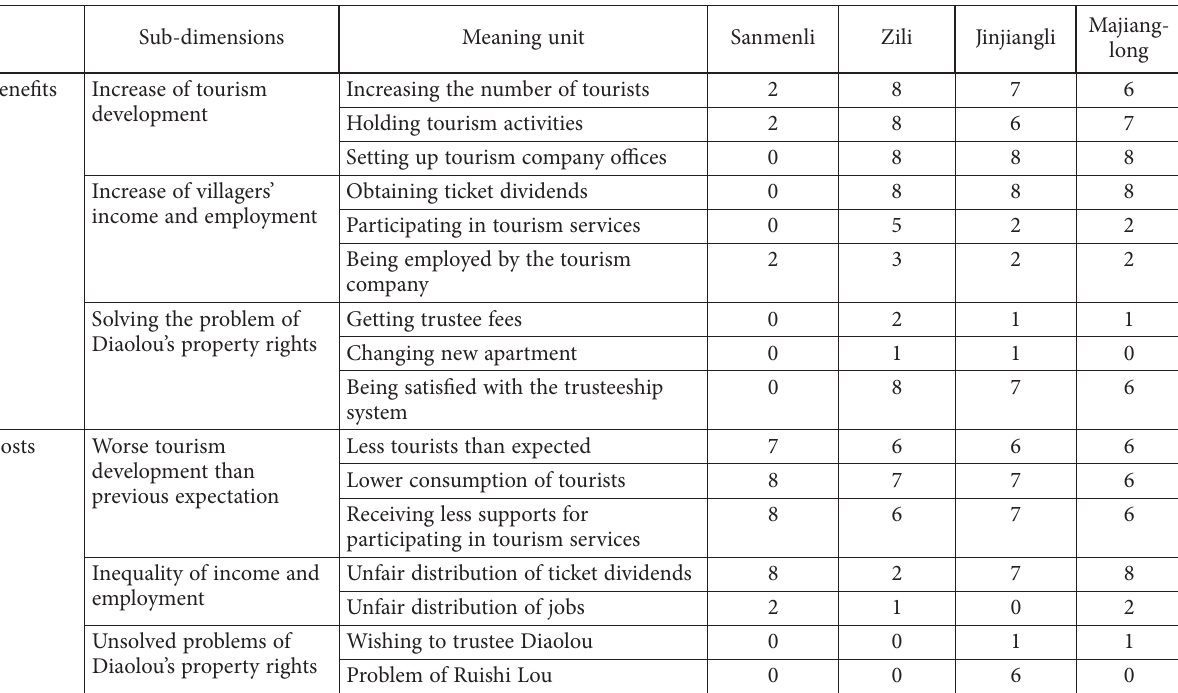
Table 6. Economic impacts of the WHL inscription (source: field survey)